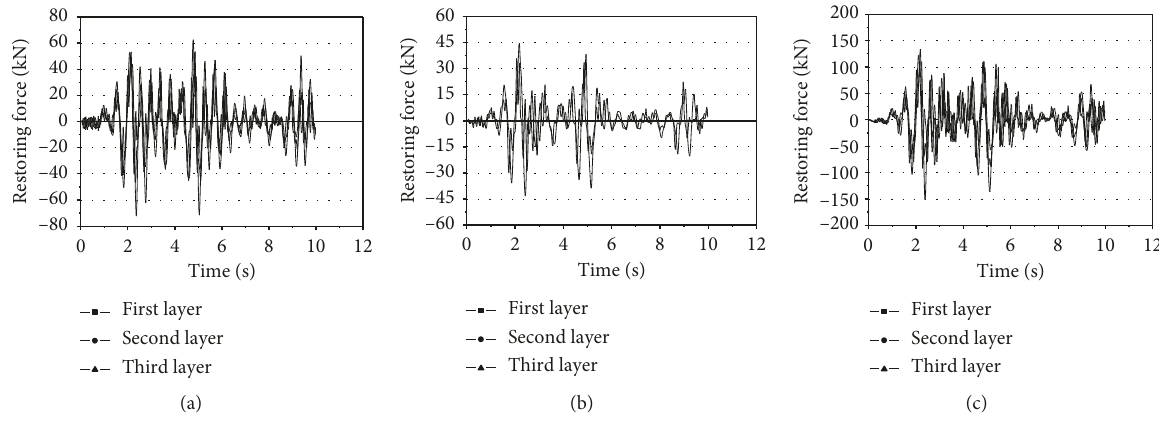
Figure 6: Restoring force time-history curves of the prestressed fabricated concrete frame. (a) PGA � 2 × 34gal. (b) PGA � 3 × 34gal. (c) PGA � 6 ×